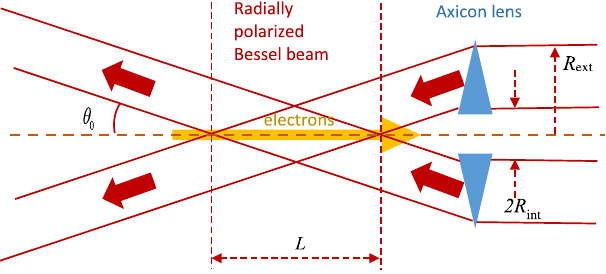
FIG. 1. An axicon lens converts a radially polarized annular ð R int < r < R ext Þ laser beam to an OBB on axis. The electrons counterpropagate against the Bessel beam. The laser beam propagates at an angle θ 0 relative to the axis; the radial electric field before the axicon lens is E r; 0 , which translates on axis after the axicon to an amplitude E z; 0 ≡ E 0 ¼ E r; 0 sin θ 0 . Not to